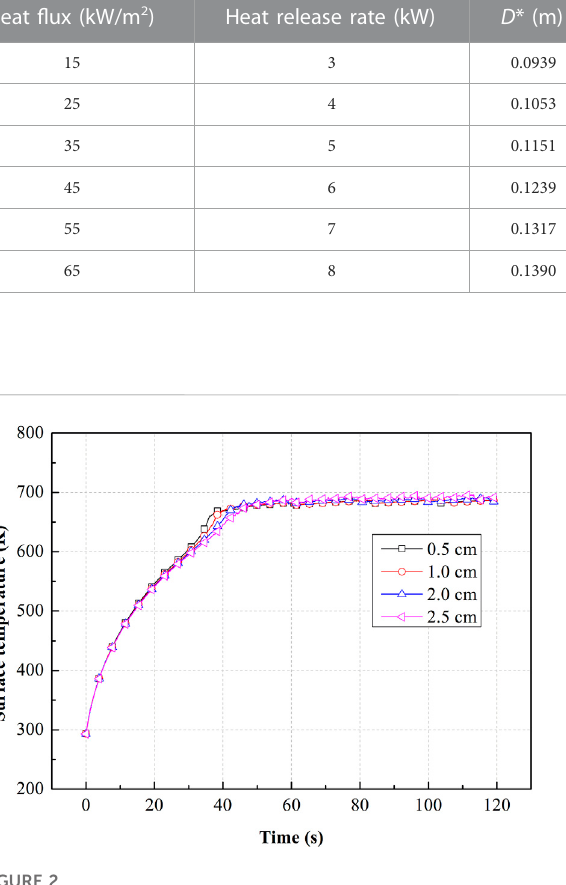
FIGURE 2 Surface temperature of samples with different grid sizes under radiant heat fl ux 50 kW/m 2 .